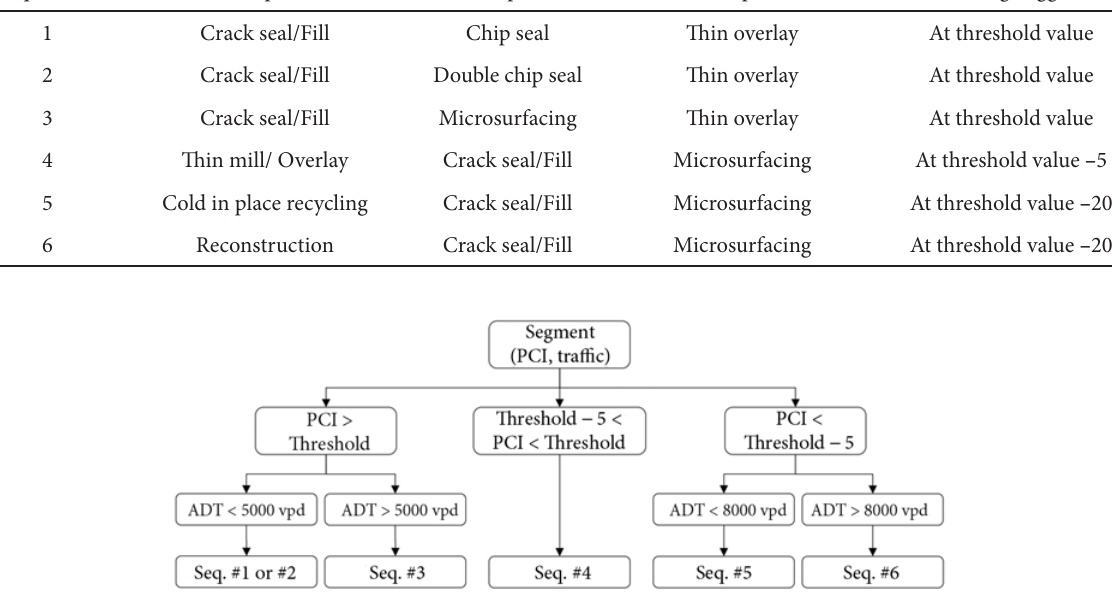
Fig. 8. Sequence decision